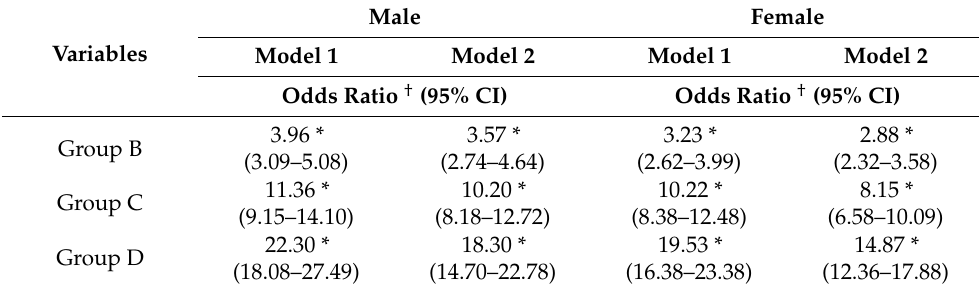
Model 1: crude odds ratio, Model 2: model 1 + controlled variables (academic performance, economic status and deterioration post-COVID 19, type of residence, post-COVID 19 physical activity, tobacco use, alcohol